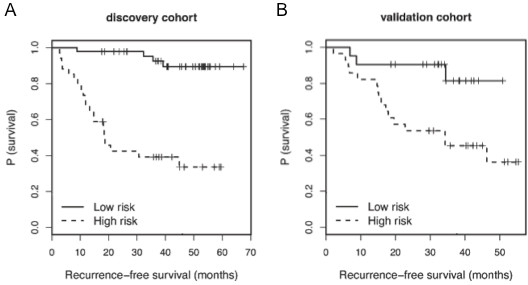
Kaplan-Meier analysis for RFS by recurrence risks defined by the Cox proportional hazards model. Patients defined as high recurrence risk (dashed line) by the Cox proportional hazards model demonstrated significantly reduced RFS compared to patients defined as low recurrence risk (solid line) in both the (A) discovery (p = 0.0036 by log rank test) and (B) validation (p = 0.009 by log rank test) cohorts